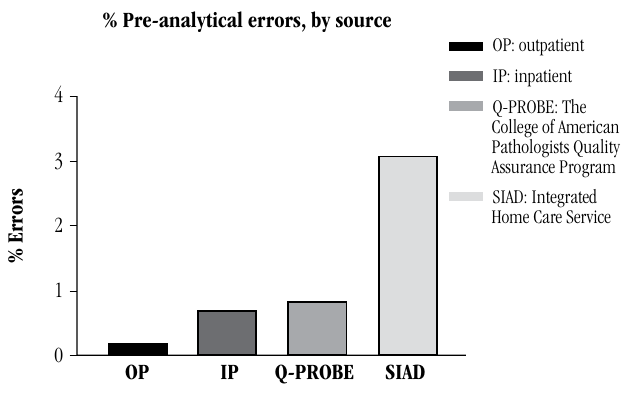
figurE 1 – Relative frequency of pre-analytical errors, by source, compared to the limits accepted in the program Q-PROBE